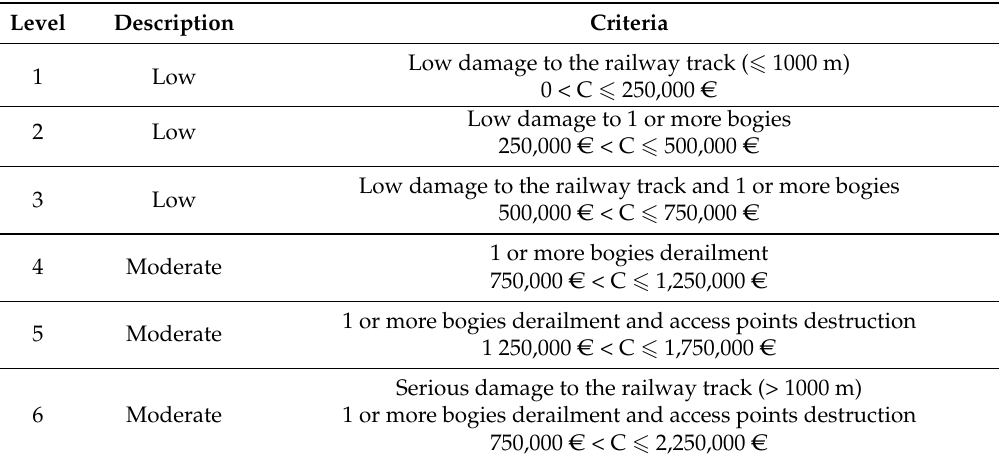
Table 3. Evaluation criteria to assess infrastructure